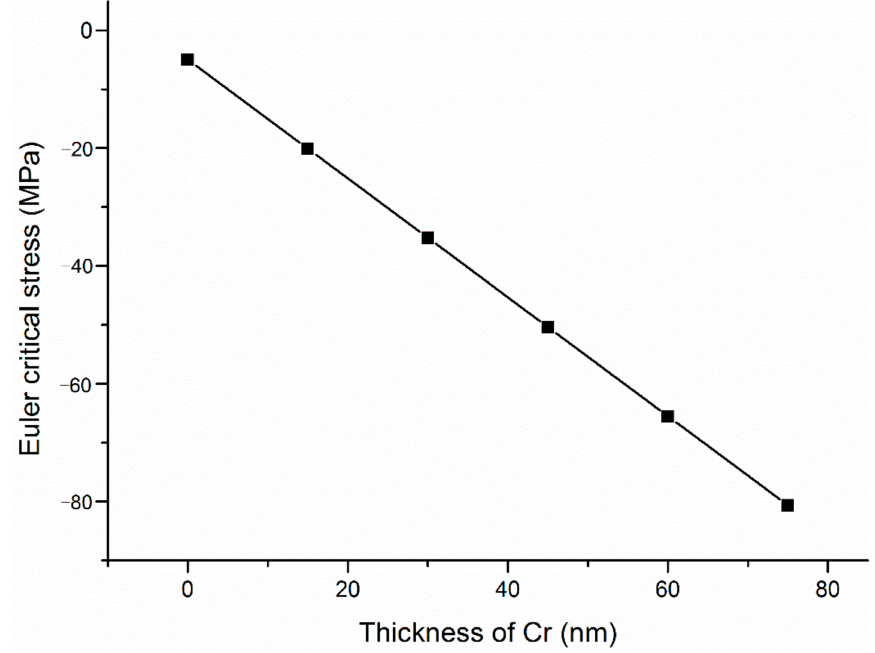
Figure 6. Relationship between Euler stress and Cr thickness.